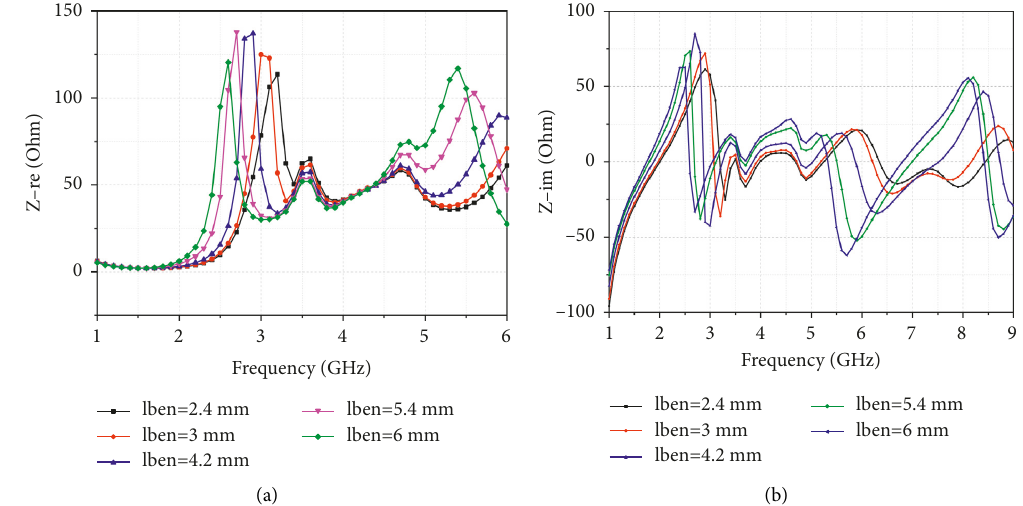
Figure 11: Input impedance of antenna 4 with a different parameter lben . (a) The real part of input impedance. (b) The imaginary part of input impedance.